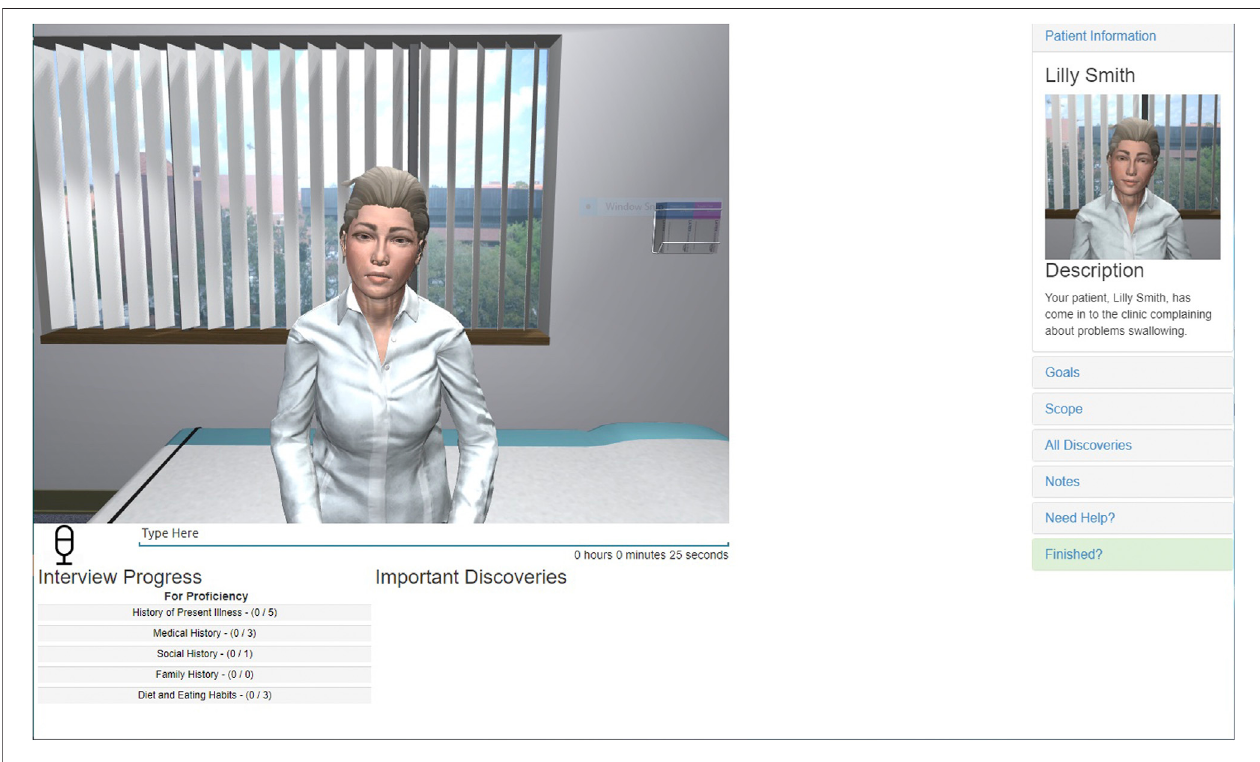
FIGURE 1 | The VPF2 chat interface with virtual patient Lilly Smith.